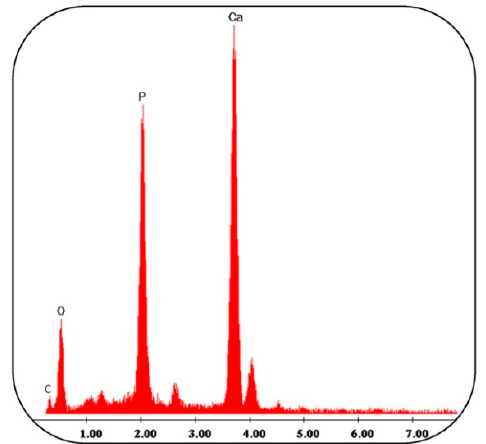
Figure 7. The analysis of the EXT0.5 thread after soaking in a simulated body fluid (SBF) solution for 21 days.